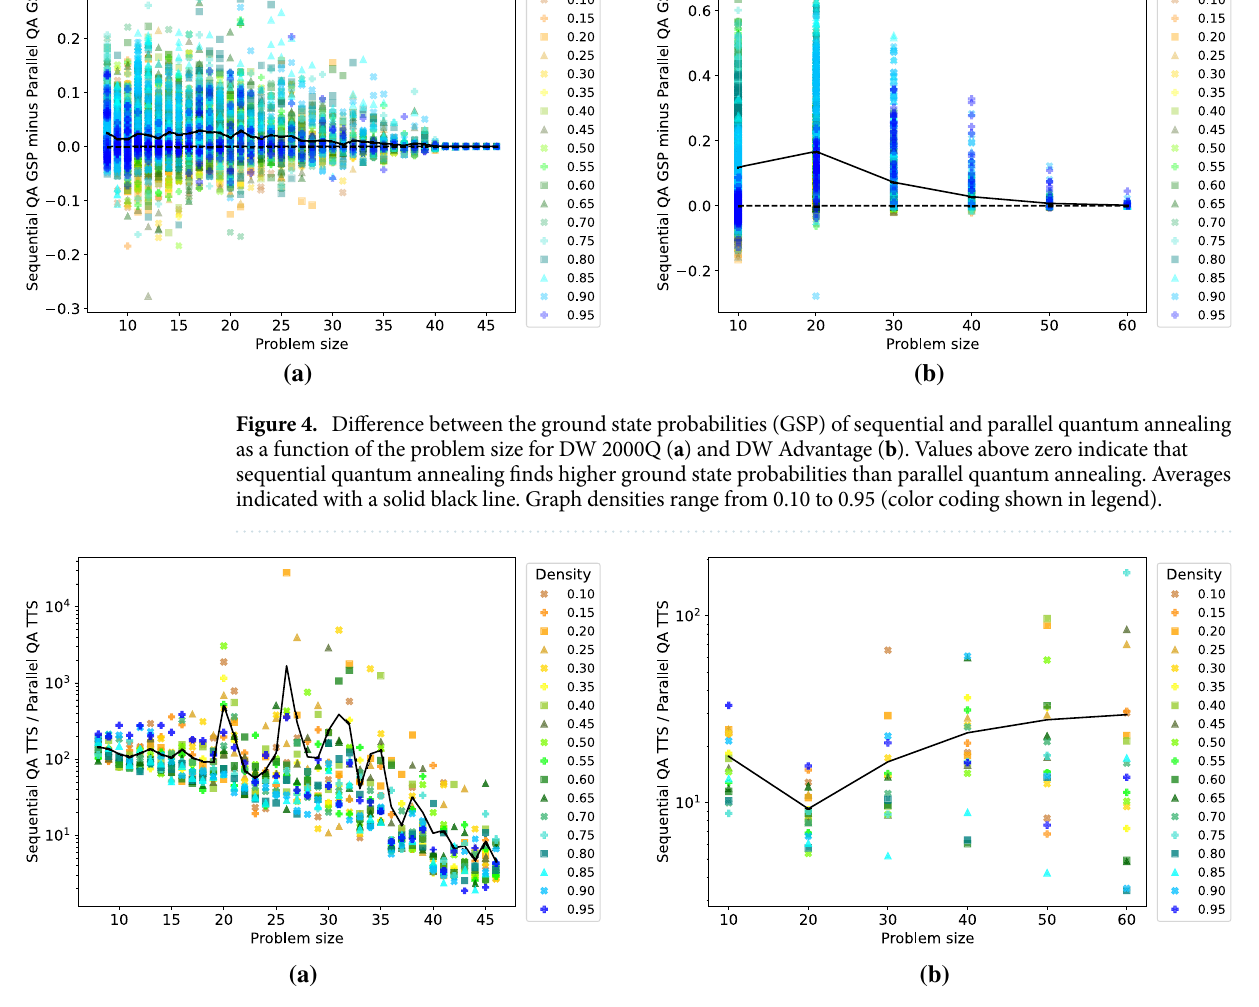
Figure 5. TTS speedup of using parallel quantum annealing compared to sequential quantum annealing as a function of the problem size for D-Wave 2000Q ( a ) and D-Wave Advantage 1.1 ( b ). The TTS speedup is computed as the quotient of the sequential and parallel TTS metrics. Mean values are shown by the solid black line. Graph densities range from 0.10 to 0.95 (color coding shown in the